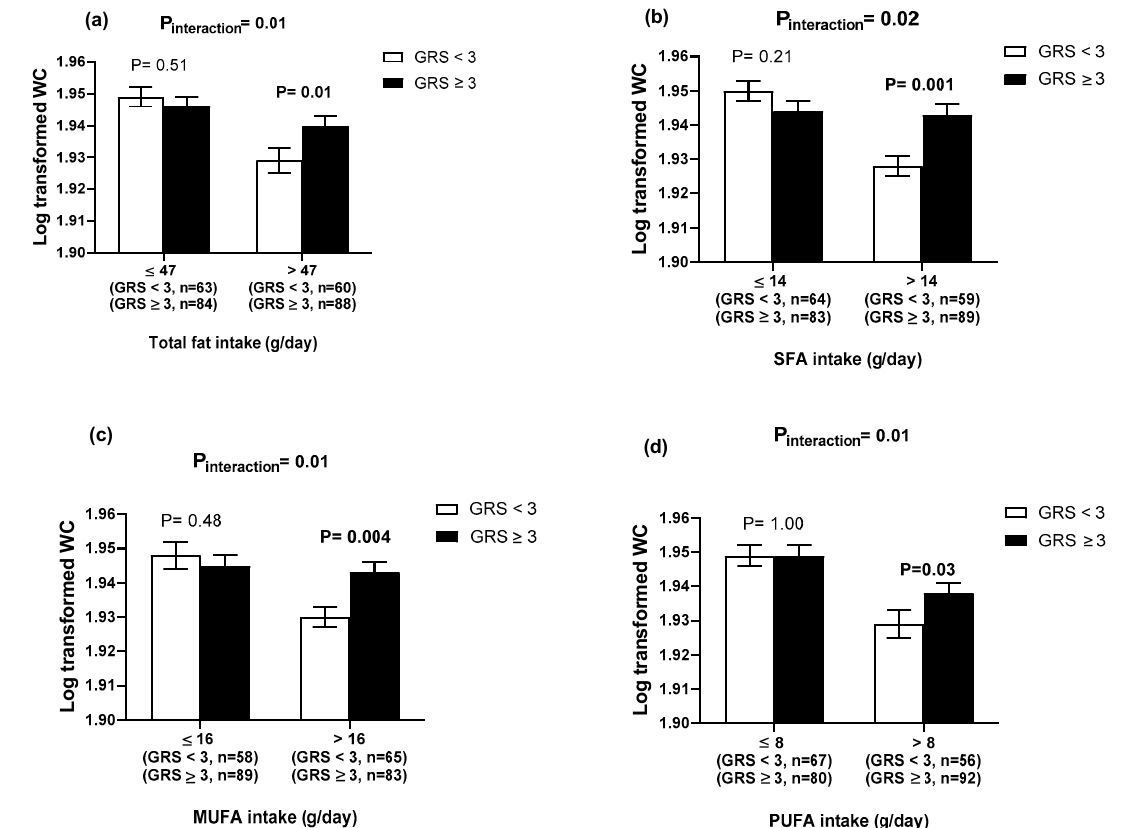
Figure 2. Interaction between the 4-SNP GRS and fat intake (g / day) on the log transformed WC. ( a ) Interaction between the 4-SNP GRS and the log transformed total fat intake (g / day) on WC. White bars indicate individuals with a GRS < 3 risk alleles; the black bars indicate individuals with GRS ≥ 3 risk alleles. Individuals with ≥ 3 risk alleles had a significantly higher WC compared to those with < 3 risk alleles, among individuals with a higher total fat intake (above median group > 47 g / day): 71.28 ± 23.68 g / day (34.99 ± 5.54 % TEI); ( b ) the interaction between the 4-SNP GRS and the log transformed SFA intake (g / day) on the log transformed WC. White bars indicate individuals with a GRS < 3 risk alleles; the black bars indicate individuals with GRS ≥ 3 risk alleles. Individuals with ≥ 3 risk alleles had a significantly higher WC compared to those with < 3 risk alleles, among individuals with a higher SFA intake: 23.50 ± 10.08 g / day (12.19 ± 3.21% TEI); ( c ) the interaction between the 4-SNP GRS and the log transformed MUFA intake (g / day) on the log transformed WC. White bars indicate individuals with a GRS < 3 risk alleles; the black bars indicate individuals with GRS ≥ 3 risk alleles. Individuals with ≥ 3 risk alleles had a significantly higher WC compared to those with < 3 risk alleles, among individuals with a higher MUFA intake: 25.72 ± 9.58 g / day (12.79 ± 2.53% TEI); ( d ) the interaction between the 4-SNP GRS and the log transformed PUFA intake (g / day) on the log transformed WC. White bars indicate individuals with a GRS < 3 risk alleles; the black bars indicate individuals with GRS ≥ 3 risk alleles. Individuals with ≥ 3 risk alleles had a significantly higher WC compared to those with < 3 risk alleles, among individuals with a higher PUFA intake: 12.74 ± 4.7 g / day (6.28 ± 1.08% TEI). Abbreviations: SNP: single nucleotide polymorphisms; GRS: genetic risk